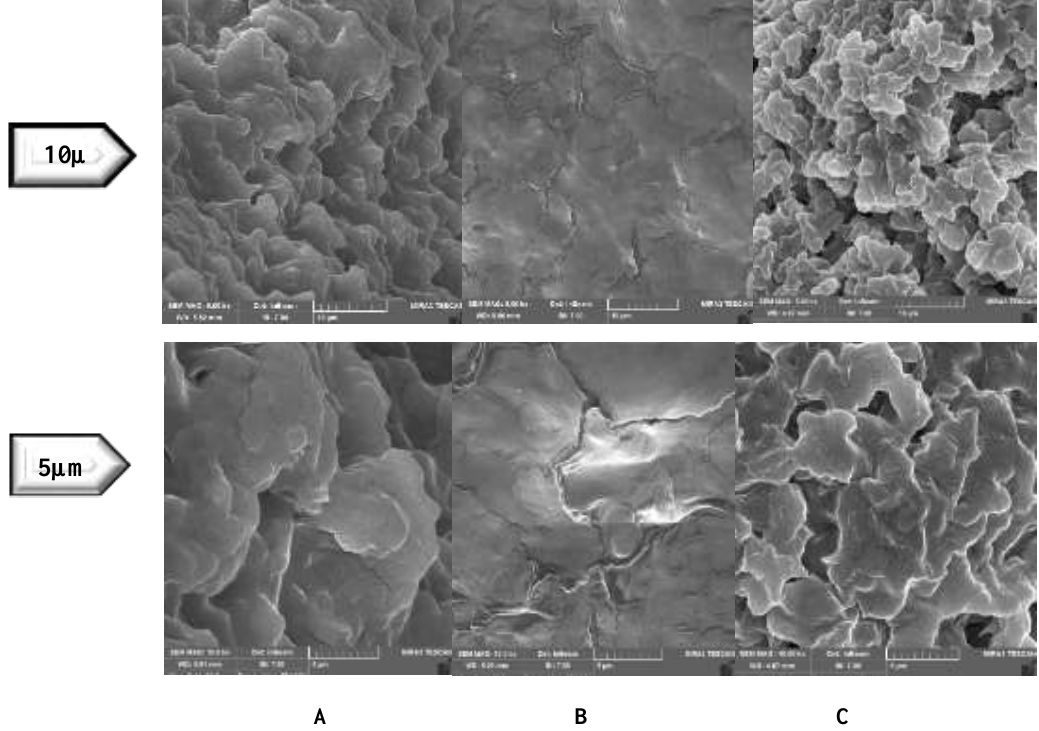
Figure 2 (A, B, C): FE-SEM images with two magnification powers (10 and 5)µm to clarify the differences among all samples morphologies such as pores, features size and shape, and grain formation, etc. related to CHT blends with (0.04, 0.06, 0.08) g of MgO nanopowder,